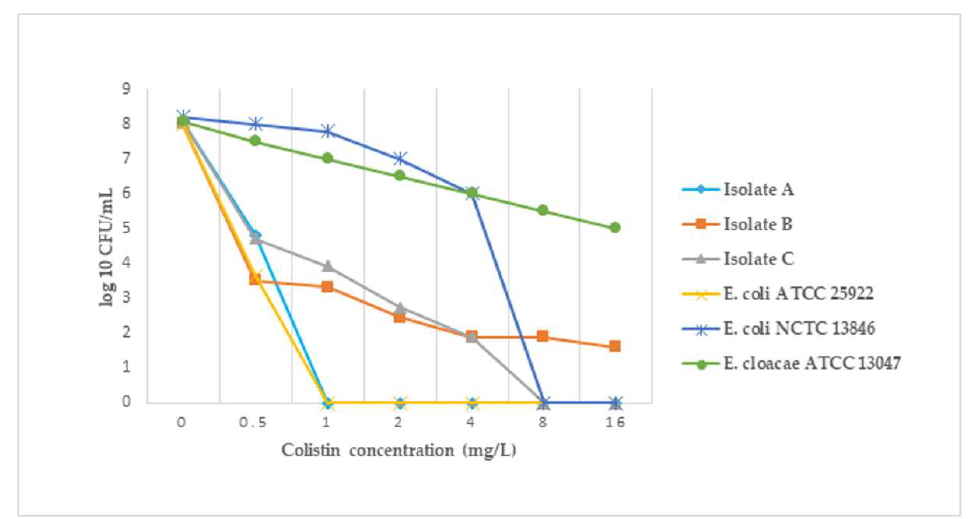
Figure 2. The population analysis profile of isolates A (susceptible), B, C (heteroresistant), and the reference strains at an initial inoculum of 10 8 CFU/mL The data shown are representative of multiple replicates performed in the same experiment and on different working days for each strain.